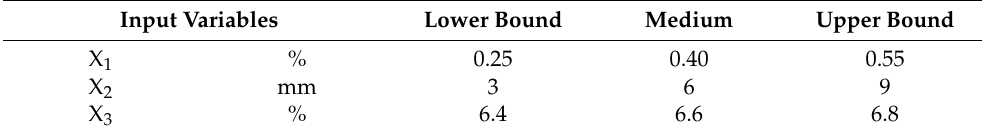
Table 2. Range constrains of input variables.